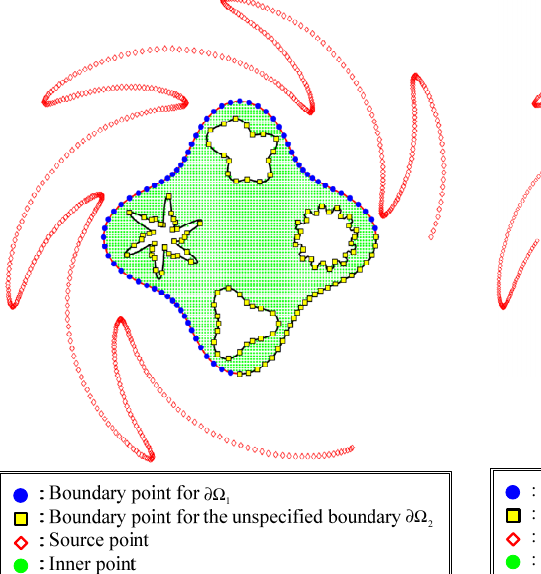
Figure 17. Location of the collocation points for Example 3: ( a ) case C and ( b ) case D.